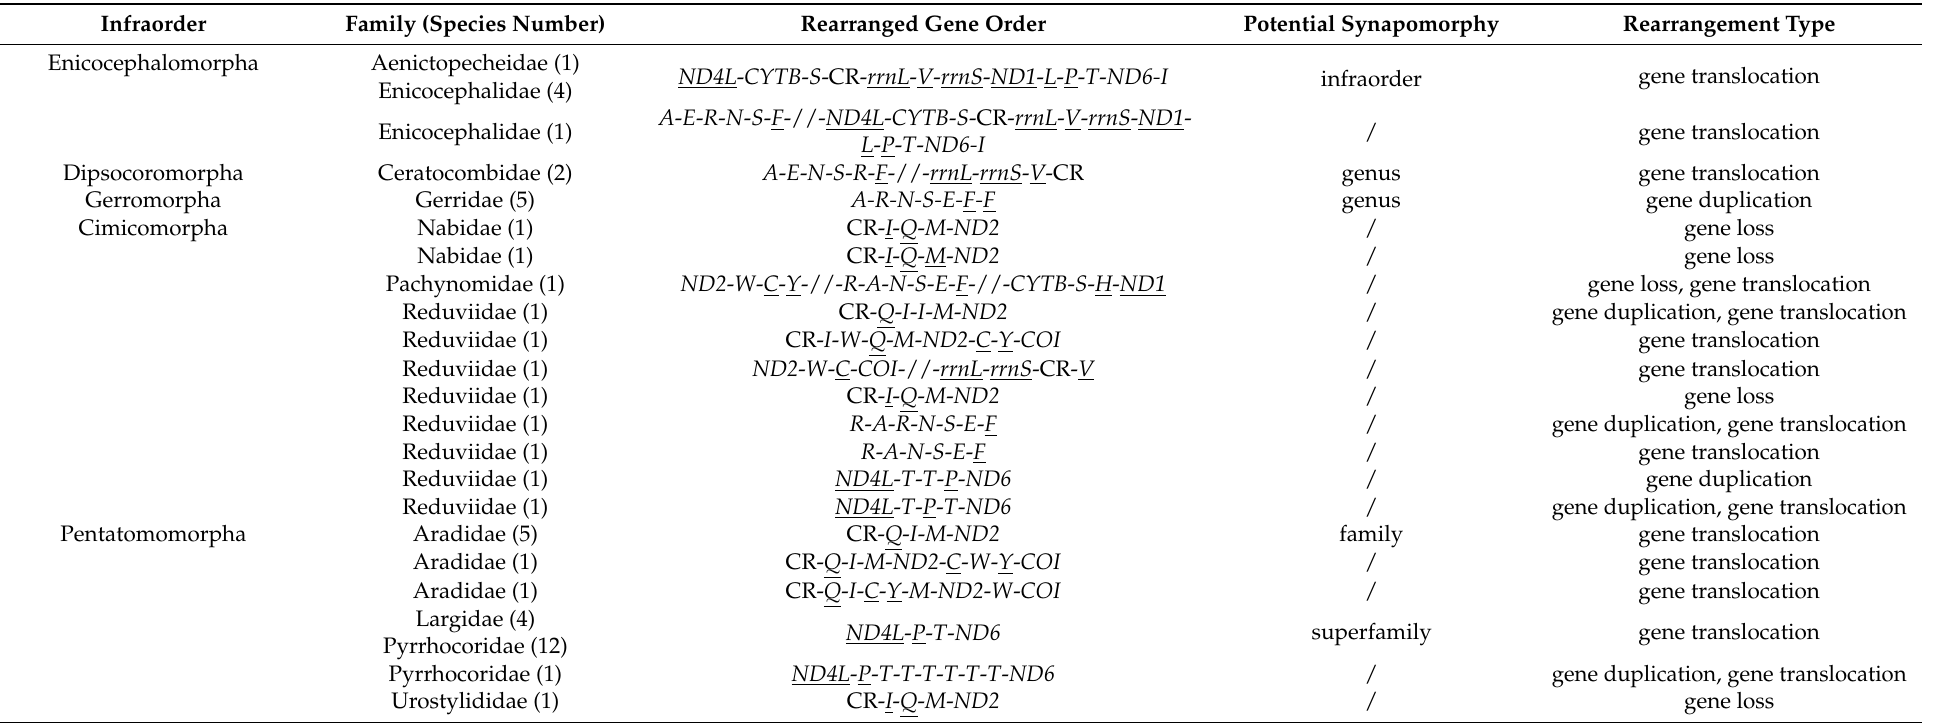
Table 1. Gene rearrangements in heteropteran